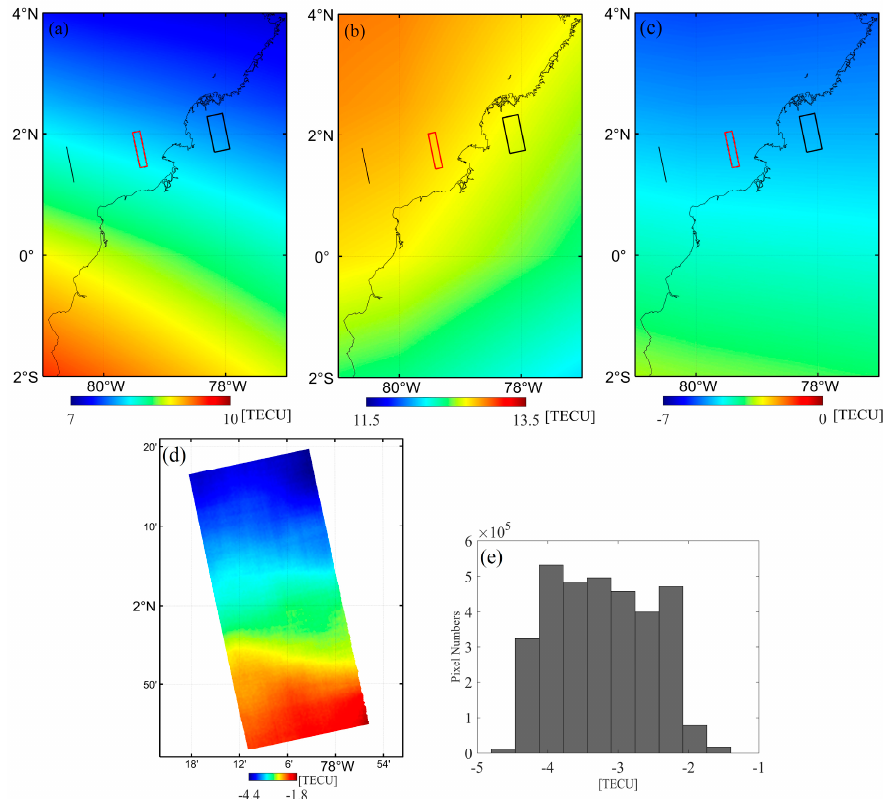
Figure 10. TEC Comparison in the Equator case: ( a , b ) TEC maps derived from the GIM model for master and slave acquisition, respectively. The black line and square denote the orbit and image ground footprint; The red square indicates the crossed region projected to the ionosphere; ( c , d ) differential TEC obtained by the GIM model and FR inversion, respectively. ( e ) The histogram of ( d ).